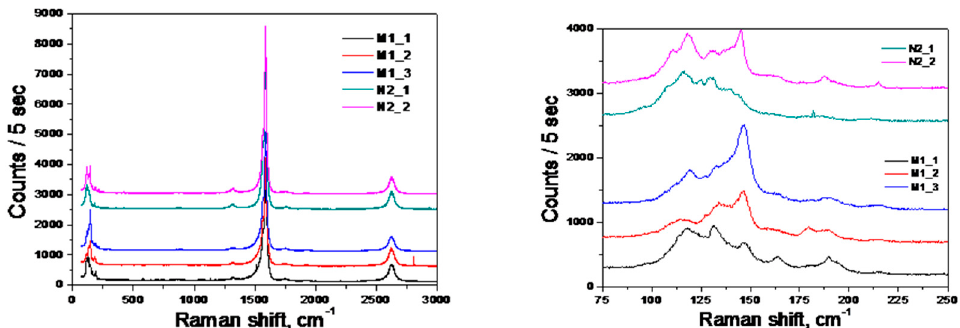
Figure 7. CNT Raman spectra before and after RESS-processing. N2_1 and N2_2 refers to the starting nanotubes, M1_1, M1_2, and M1_3—to the nanotubes after the RESS-processing with CO 2 at a pressure of 75 bar and temperature of 80 °C.